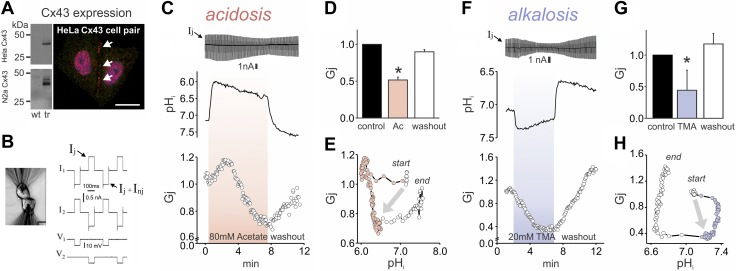
Electrical uncoupling of Cx43 cell pairs at low and high pHi. A) Cx43 protein in HeLa and N2a cells confirmed by Western blot analysis and immunostaining. Wild-type HeLa and N2a lack Cx43 endogenous. Multiple bands correspond to Cx43 phosphorylation states. Cx43 localizes at the interface between cells (white arrows). Cells were stained by using anti-Cx43 Ab (red). Nuclei were labeled with DAPI (purple). Scale bar, 25 µm. B) Junctional conductance (Gj) assessed by double whole-cell voltage clamp on cell pairs. During alternating voltage pulses, junctional currents (Ij) are a readout of cell-to-cell coupling and Ij + Inj represent the junctional plus transmembrane currents in the stimulated cell. C) Example experiment showing effect of superfusion with 80 mM Na+ acetate. Junctional currents (increase indicates stronger coupling; top). Time course of pHi measured by using SNARF-1, showing rapid acidification, secondary partial recovery, and a rebound alkalinization upon washout (middle). Low pHi reduced Gj rapidly (bottom). Note the small initial transient increase in Gj, followed by a fast decrease that reached ∼70% of initial value. D) Average data (mean ± sd) for Gj at baseline conditions, reduction after 3 min of acetate, and recovery after 5 min washout (n = 5, HeLa and N2a cell pairs). E) Representative plot of pHi
vs.
Gj. After the start position (all white circles), there is a robust reduction in pHi, whereas Gj remained constant. This is followed by an increase in Gj, then a decrease. Arrow indicates the net change in Gj and pHi during the protocol. During washout (all white circles), pHi and Gj recover toward initial levels. F) Example experiment showing effect of superfusion with 20 mM TMA. Ij (top). Time course of pHi showing rapid alkalinization, secondary partial recovery, and a rebound acidification upon washout (middle). Alkaline pHi reduces Gj toward ∼50% of the initial Gj value (bottom). G) Average (mean ± sd) Gj at baseline conditions, after 3 min perfusion of TMA, and recovery after 5 min of washout (n = 5 N2a cell pairs). H) Representative plot of pHi
vs.
Gj plot. Arrow indicates net change in Gj and pHi near the steady state. *P < 0.05.